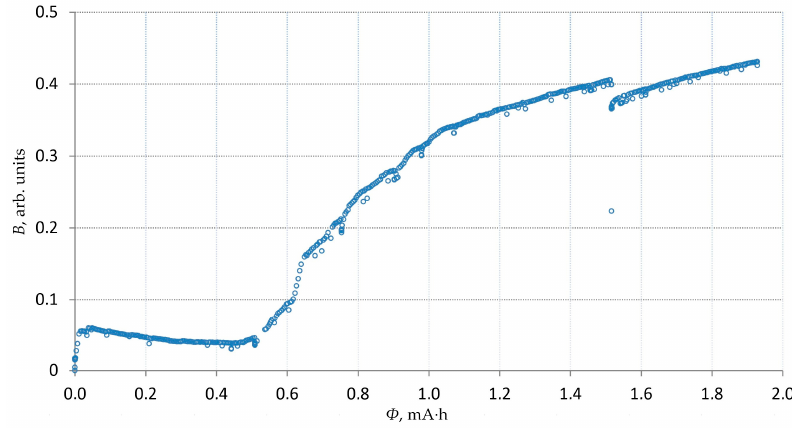
Figure 12. Change in the image brightness B vs. the accumulated integral of the proton current Ф .